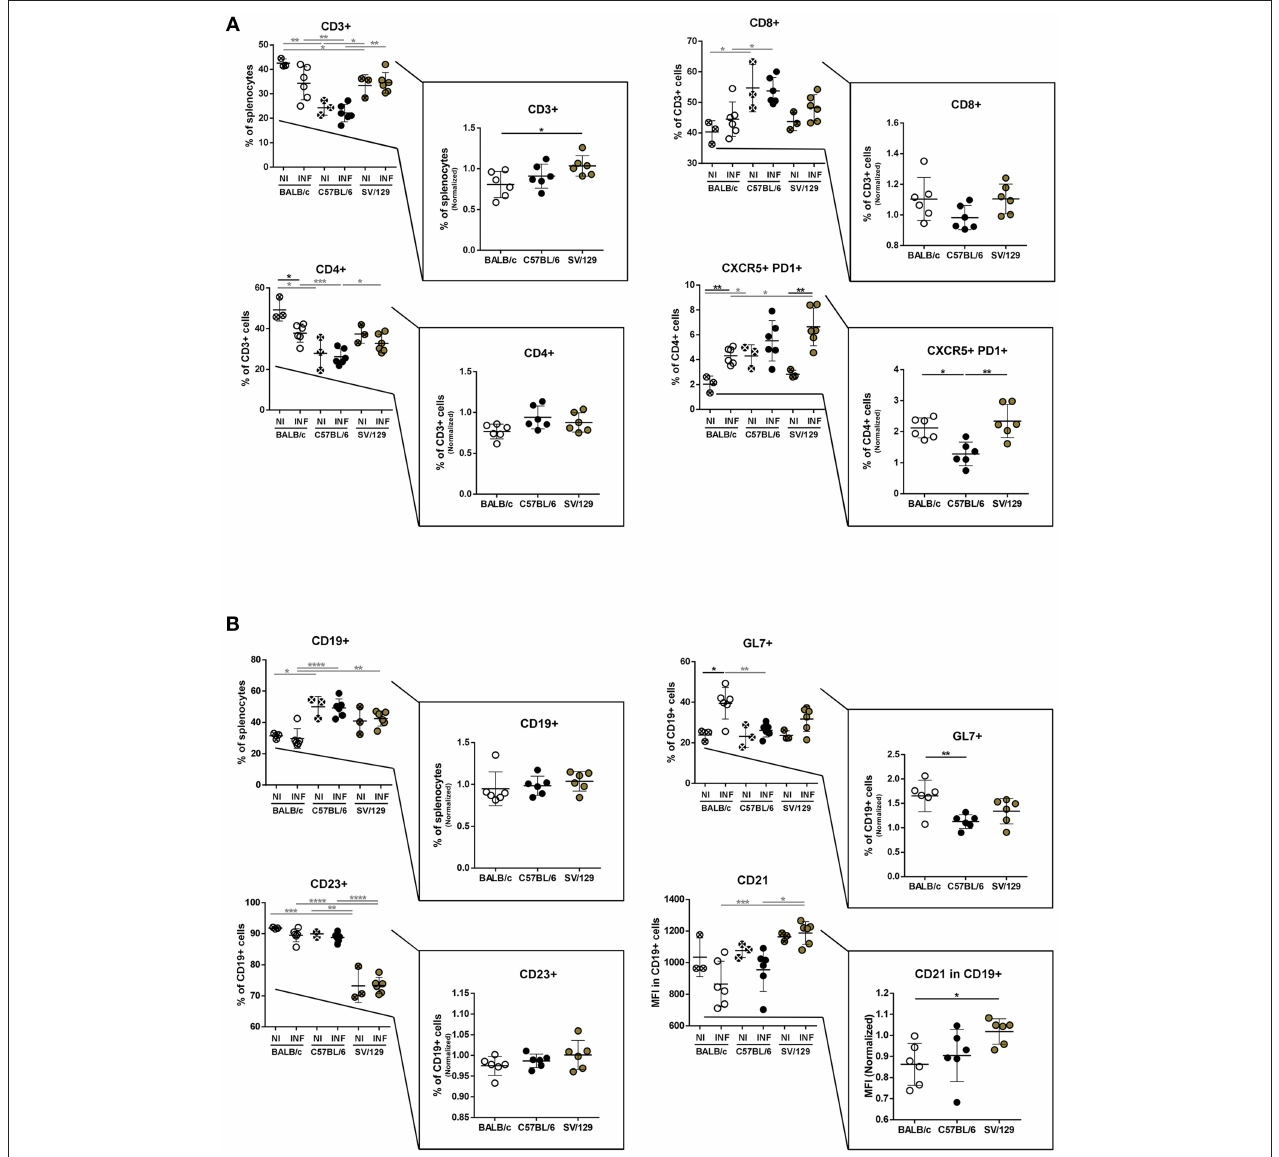
FIGURE 2 | Splenic lymphoid compartment of the different mouse strains and it’s alteration 2 weeks post L. infantum infection. BALB/c (white circles), C57BL/6 (black circles), and SV/129 (brown circles) mice were infected intraperitoneally with 1 × 10 8 L. infantum promastigotes and euthanized 2 weeks after. Splenic lymphoid populations were resolved by flow cytometry: T cell (A) and B cell (B) compartments. Results, obtained in at least two independent experiments, are represented both in total percentages (infected and control animals) and normalized (infected in relation to control group average values) as a way to highlight the infection-induced alterations. Each dot represents an animal. Average and SD of the values within each group are shown. Statistical differences are properly identified. One Way ANOVA (with Tukey’s post-hoc analysis) was used for comparisons between the different murine strains (infected or non-infected; gray lines), as well as for comparison of normalized values (black lines); t -tests (black lines) were performed for comparison between infected animals and controls from the same strain: * p ≤ 0.05, ** p ≤ 0.01, *** p ≤ 0.001, and **** p ≤